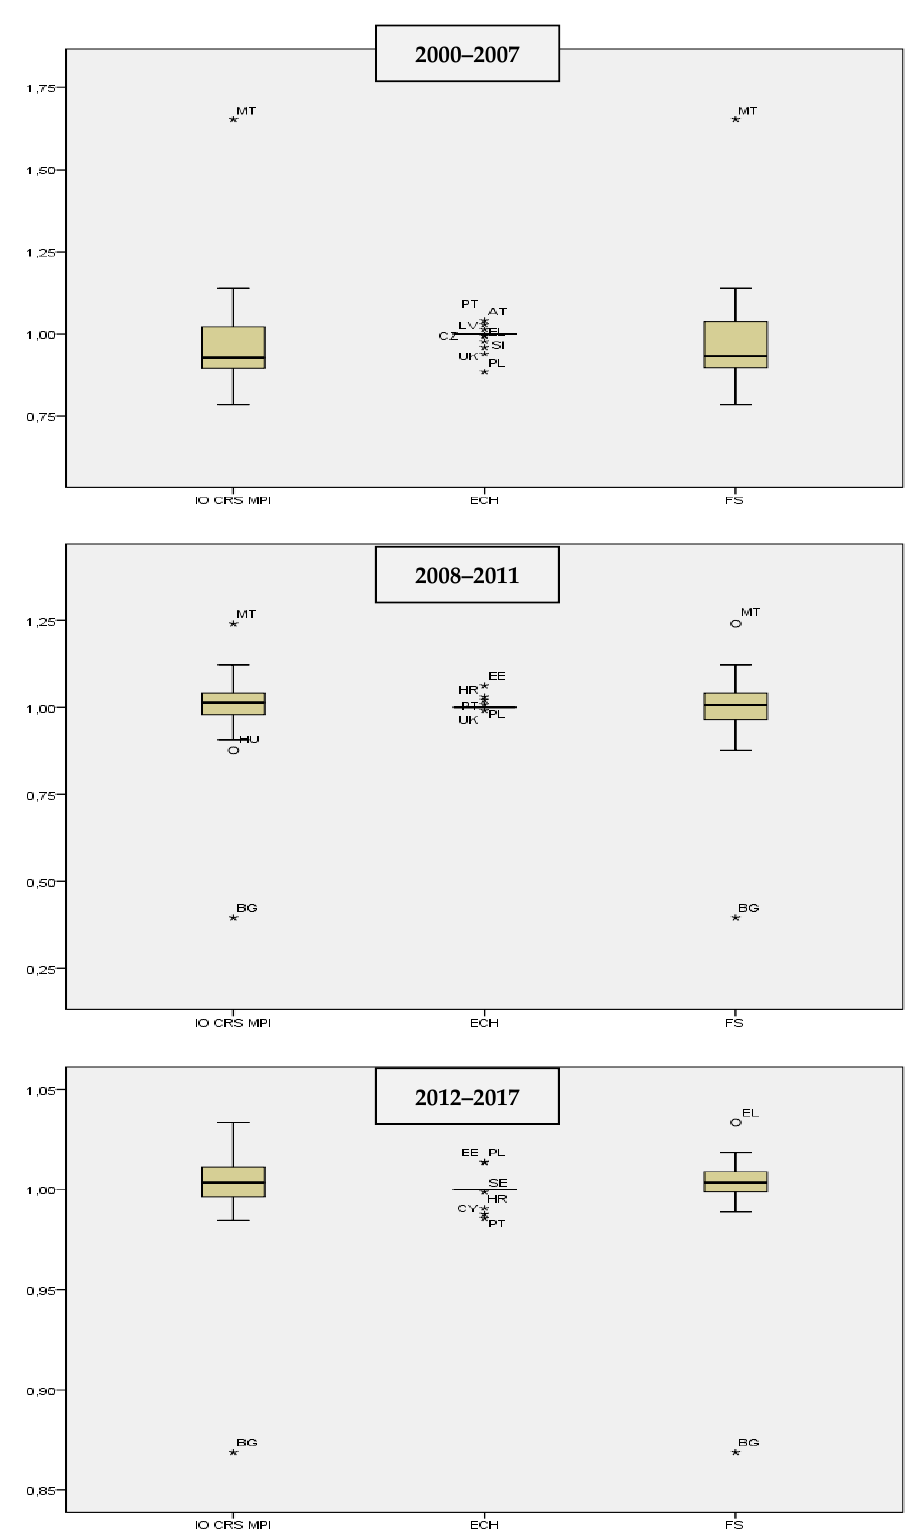
Figure 2. Box plots of Malmquist productivity index (MPI), change in relative efficiency (ECH), and change in production possibility frontier (FS)—outliers (source: own calculation and elaboration).